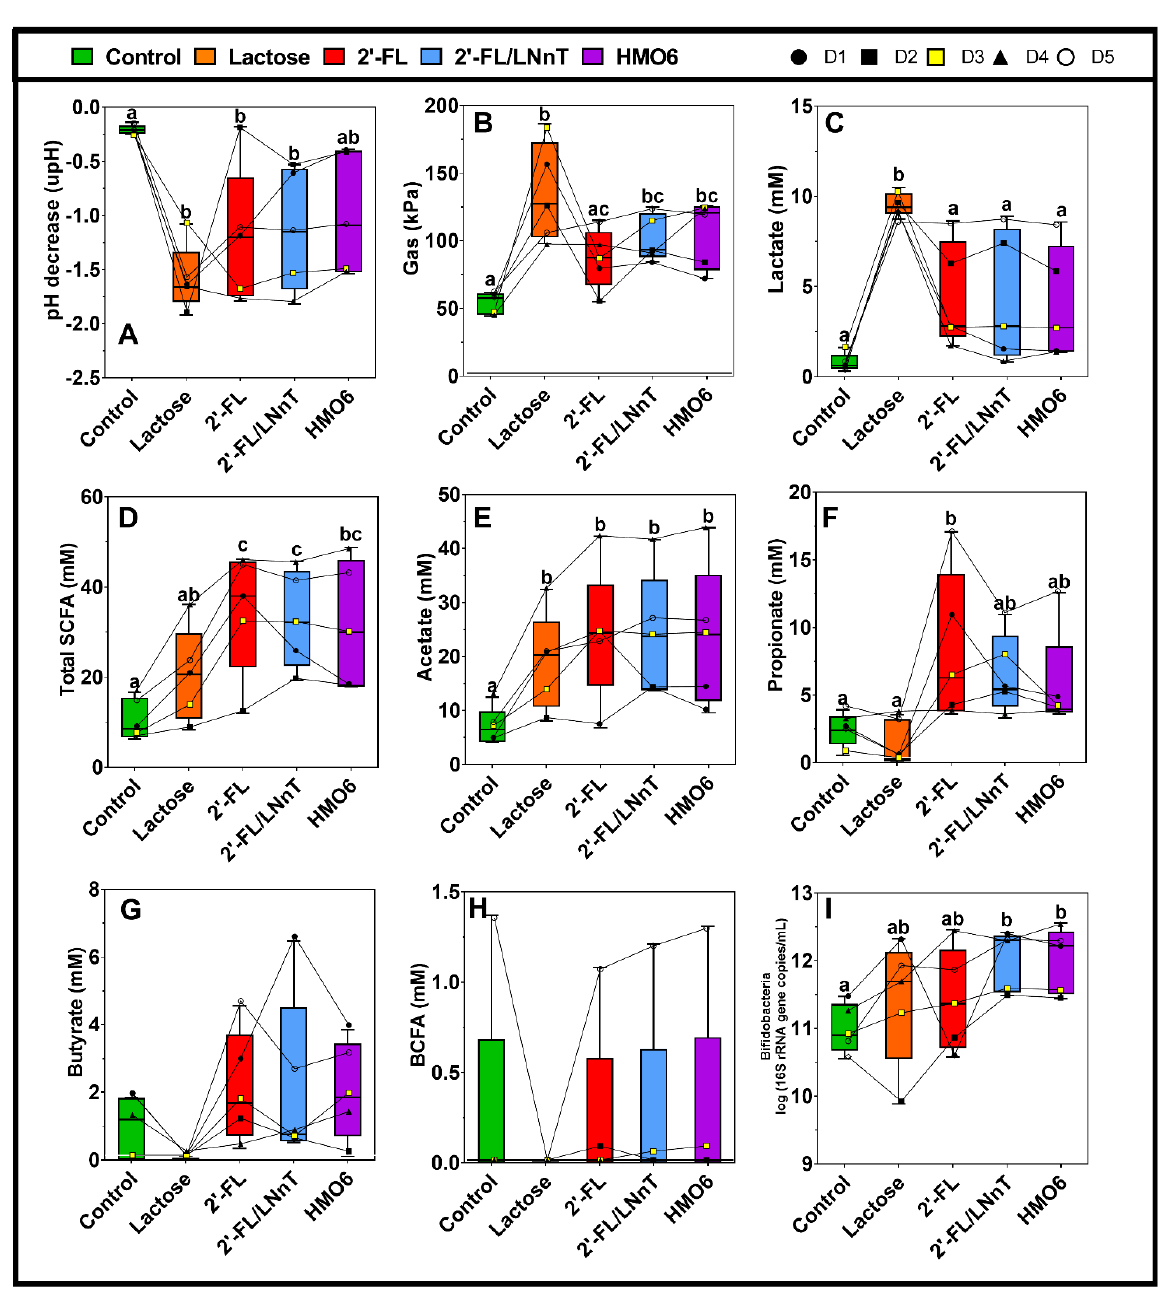
Figure 2. Effect of lactose, 2 ′ -FL, 2 ′ -FL/LNnT, or HMO6 on bacterial metabolic activity and bifidobacteria levels. ( A ) pH, ( B ) gas production, ( C ) lactate, ( D ) total SCFA, ( E ) acetate, ( F ) propionate, ( G ) butyrate, ( H ) BCFA, and ( I ) bifidobacteria levels during short-term fecal batch incubations (0–48 h), upon treatment with lactose, 2 ′ -FL, 2 ′ -FL/LNnT or HMO6. Box plots represent median and interquartile range (n = 5 donors, N = 3). Each line shows the effect of each treatment for one donor. Significant differences between treatments (one-way ANOVA with Bonferroni correction for all metabolic markers except BCFA which was analyzed with Friedman test with Dunn’s correction, due to normality assumption violation) are indicated with different letters (a, b, c; p < 0.05). Treatments sharing at least one letter are not significantly different.